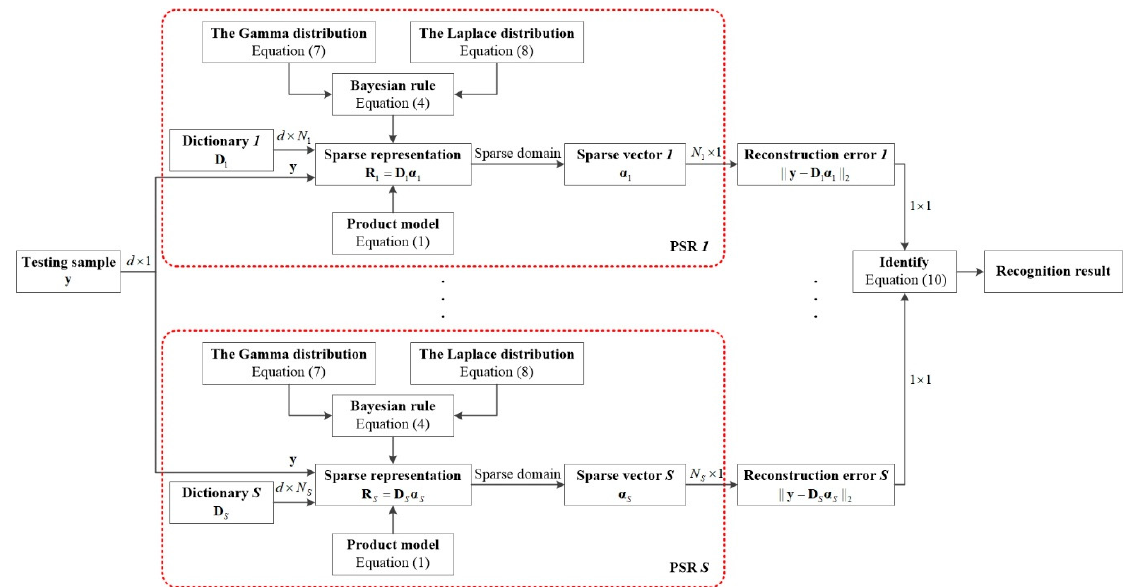
Figure 1. The flow diagram of the proposed algorithm.